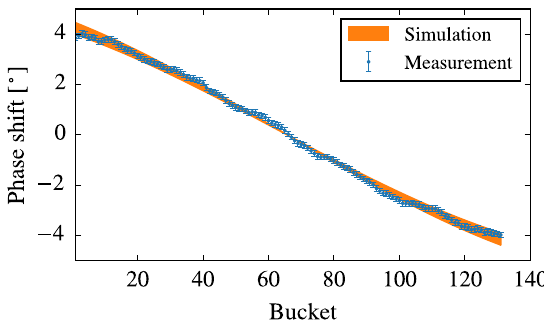
FIG. 9. Measured and simulated synchronous phase shift as function of bucket number for 100 mA average current and 131 filled buckets. The simulation result is plotted for a main cavity range between 988.3 kV (upper limit) and 1026 kV (lower limit). The error bars on the measurement corresponds to the error in the fit of the phase